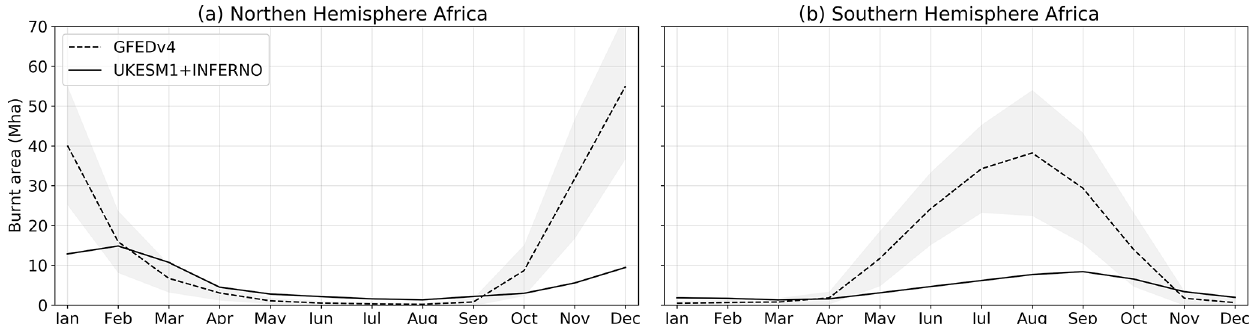
Figure 5. Burnt area fraction climatology (%) for UKESM1+INFERNO (solid line) and GFEDv4 (dashed line) with the shaded area repre- senting the standard error around the GFEDv4 data for NHAF (a) and SHAF (b) .